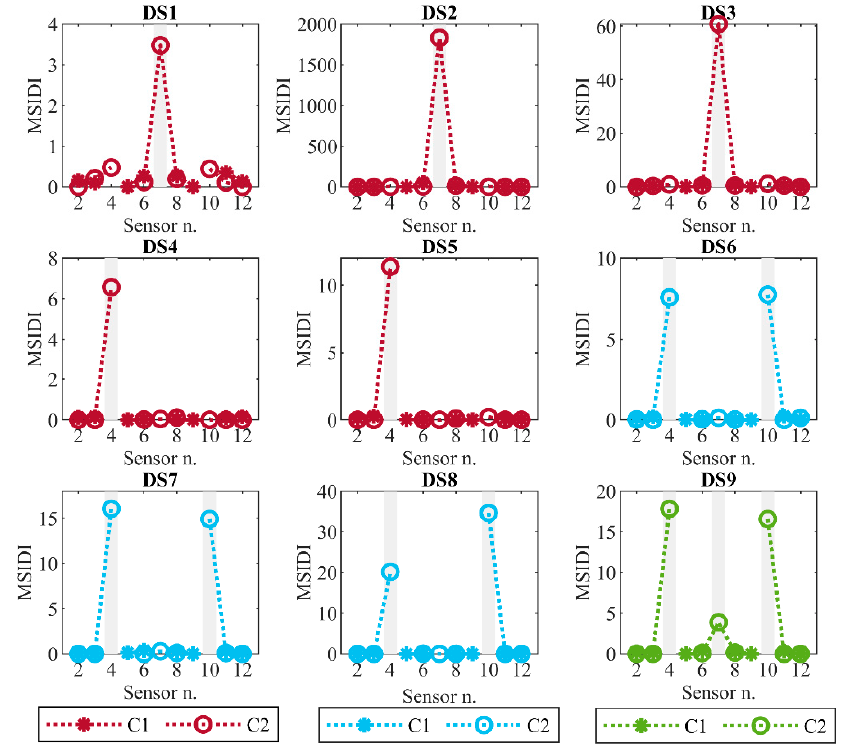
Figure 6. Numerical benchmark: Damage indexes for different damage scenarios and sensor subset configurations. The grey bars highlight the damage locations.